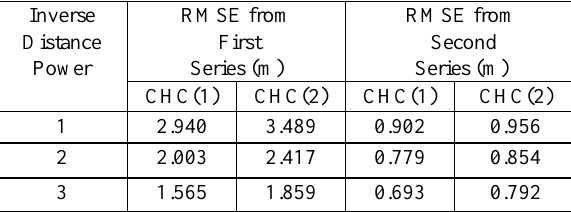
Table 5. Results from IDW Optimisation Method with